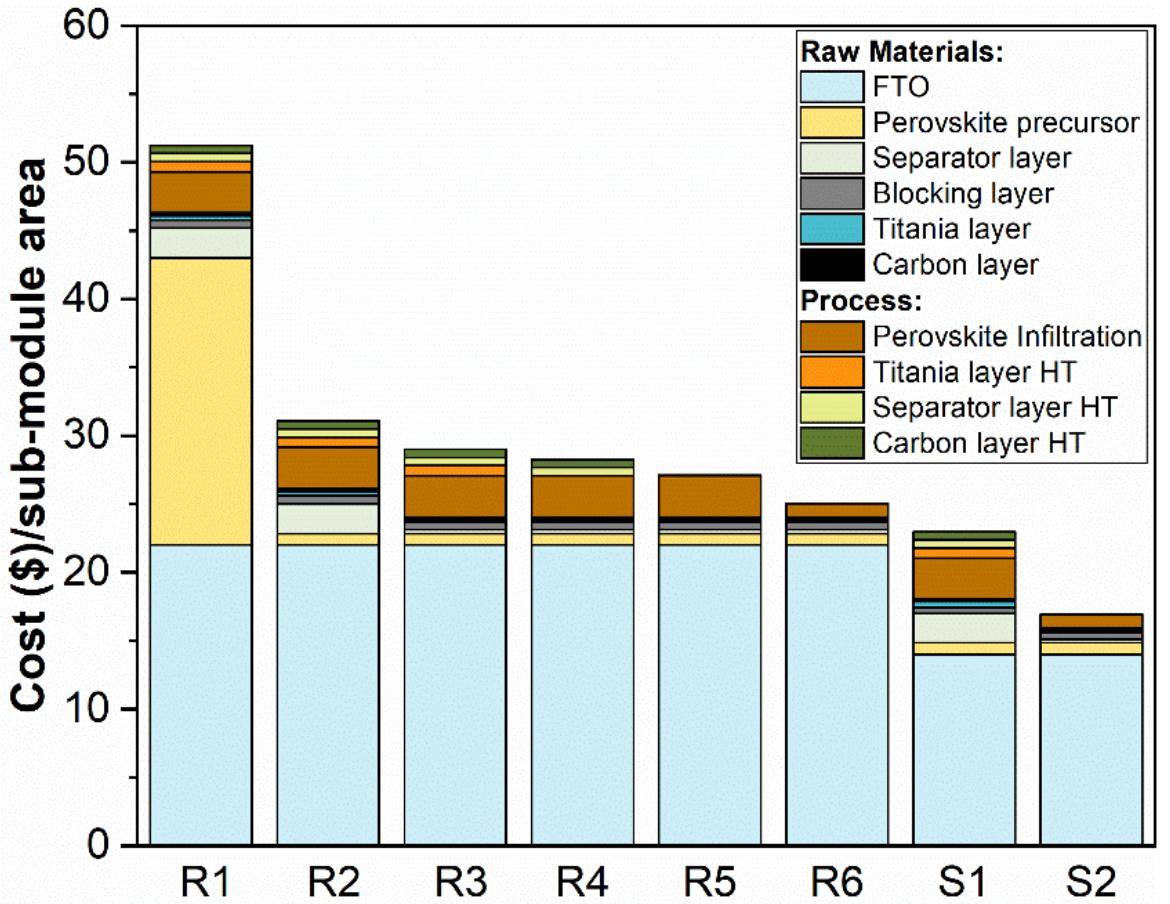
Figure 4. Manufacturing cost of different modules fabricated using the registration (R-series) or scribing (S-series) techniques. R1: commercially available pastes/two-step perovskite deposition/3 conventional heat treatments (HT); R2: commercially available pastes/one-step perovskite deposi- tion/3 conventional HTs; R3: low-cost pastes/one-step perovskite deposition/3 conventional HTs; R4: low-cost pastes/one-step perovskite deposition/2 conventional HTs; R5: low-cost pastes/one-step perovskite deposition/NIR treatment; R6: low-cost pastes/one-step perovskite deposition/NIR treatment/ambient atmosphere; S1: commercially available pastes/one-step perovskite deposition/3 conventional HTs; S2: low-cost pastes/one-step perovskite deposition/NIR treatment/ambient atmo- sphere. Note: R2 and S1 module costs were calculated based on experimental data, and for the rest of the devices, the module costs were calculated based on the proposed manufacturing